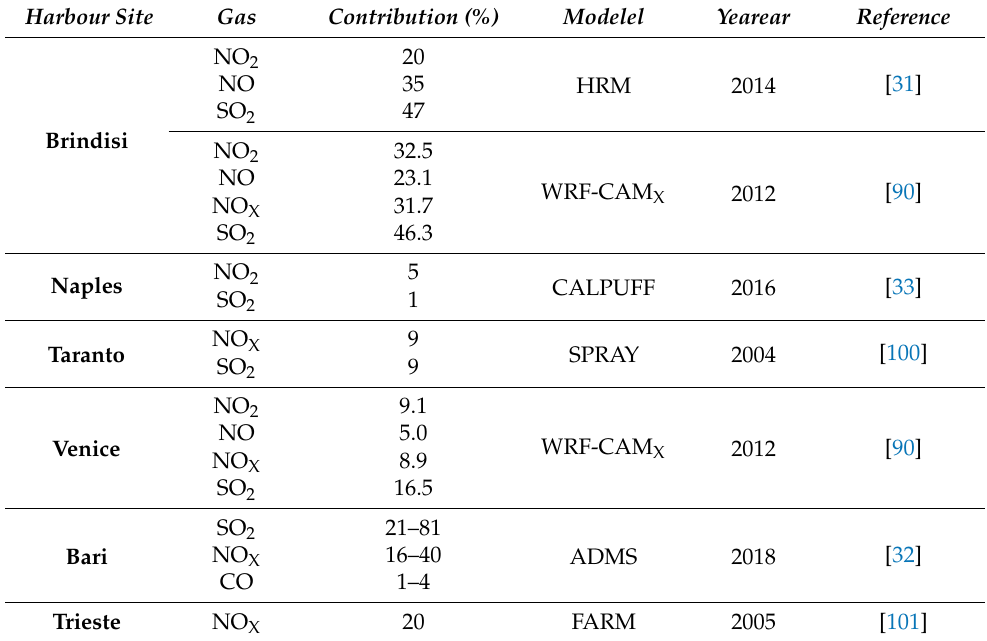
Table 1. Shipping contributions to the main gaseous pollutants in some Italian harbours, estimated by different receptor-modeling different approaches. Harbour Site Gas Contribution (%) Modelel Yearear